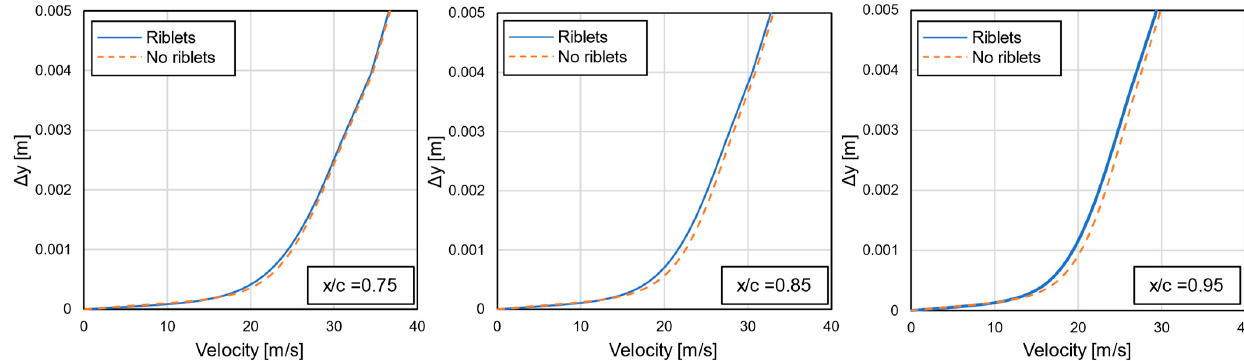
Figure 17. Velocity profiles on the empennage plane at selected positions at design conditions.